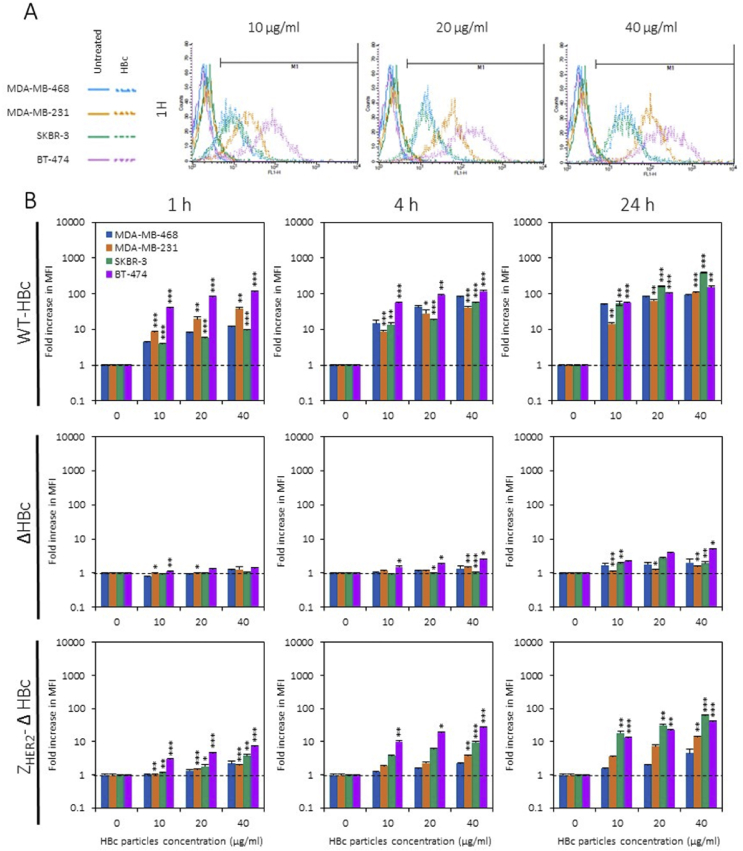
In vitro targeting studies using HBc particles. (A) Fluorescence intensity histogram of cells treated with WT-HBc particles. (B) Fold increase in median fluorescence intensity, relative to naïve cells, of cells treated with fluorescently labelled Alexa Fluor™ 488 WT-HBc, ΔHBc or ZHER2-ΔHBc particles at increasing concentrations of 10, 20 or 40 μg/mL. Flow cytometry confirmed the non-specific uptake of WT-HBc particles by cancer cell lines in a time- and dose-dependent manner. ΔHBc particles showed a significant reduction in uptake, supporting the hypothesis that the deletion of the arginine-rich domain can reduce the non-specific binding ability of wild type HBc particles. Specific uptake of ZHER2-ΔHBc particles in HER2 (+) and (+++) cells is occurred in a time-, dose- and HER2-dependent manner. Values are expressed as fold increase ±SD. *P < 0.05, **P < 0.01, ***P < 0.001, relative to MDA-MB-468 cell line (one-way ANOVA test).